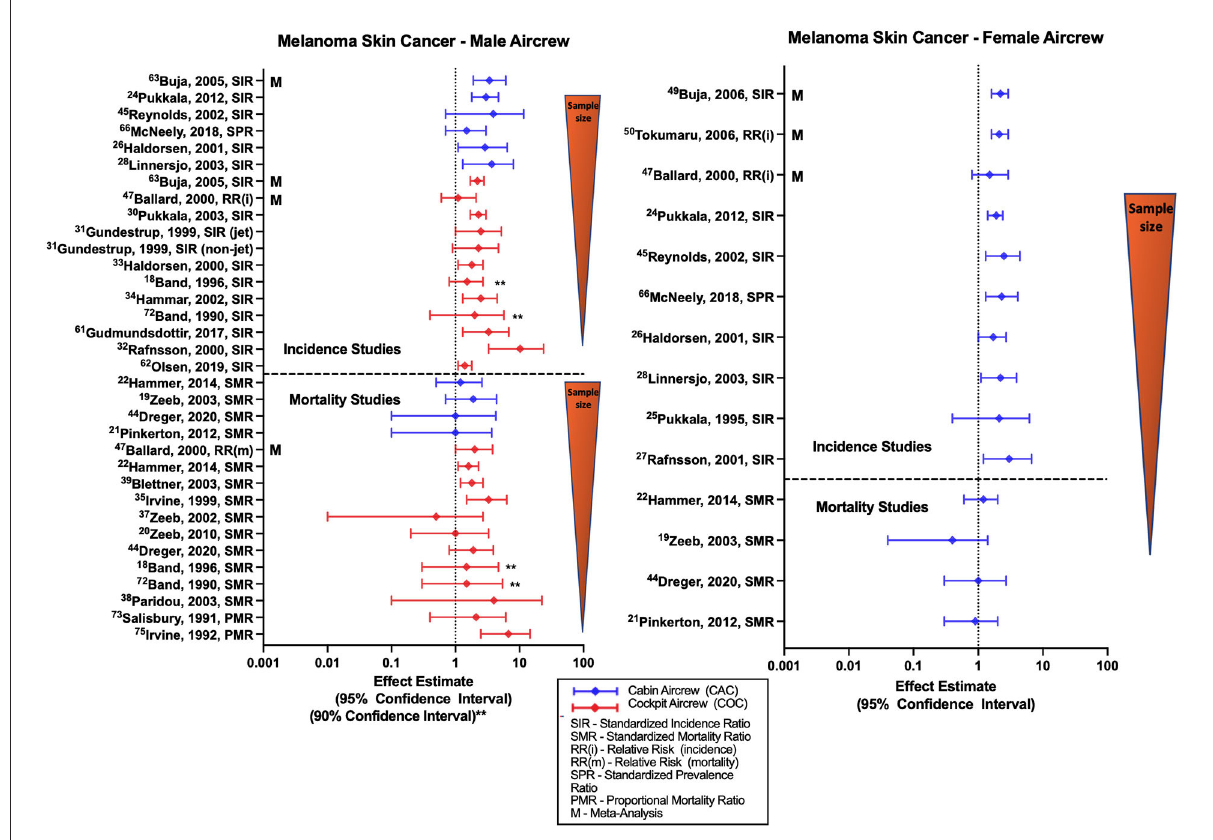
FIGURE2 Forest plot for studies evaluating melanoma skin cancer incidence or mortality ratios among male (left hand side graph) and female aircrew (right hand side graph) in association to CIR